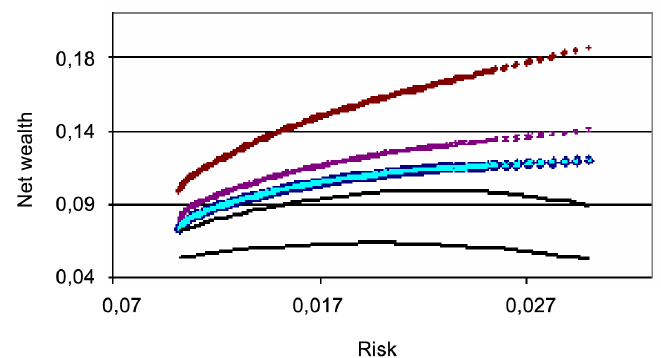
Fig. 4. Izoguarantees or the regional competitiveness